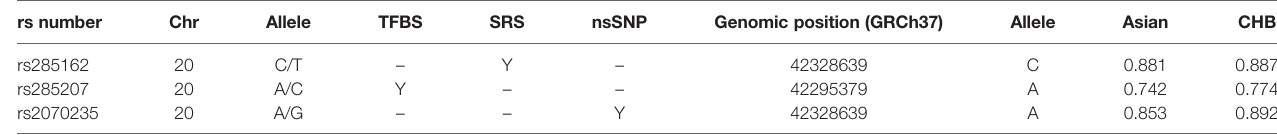
TABLE 2 | SNPs captured by the three selected MYBL2 polymorphisms as predicted by SNPinfo software (http://snpinfo.niehs.nih.gov/).